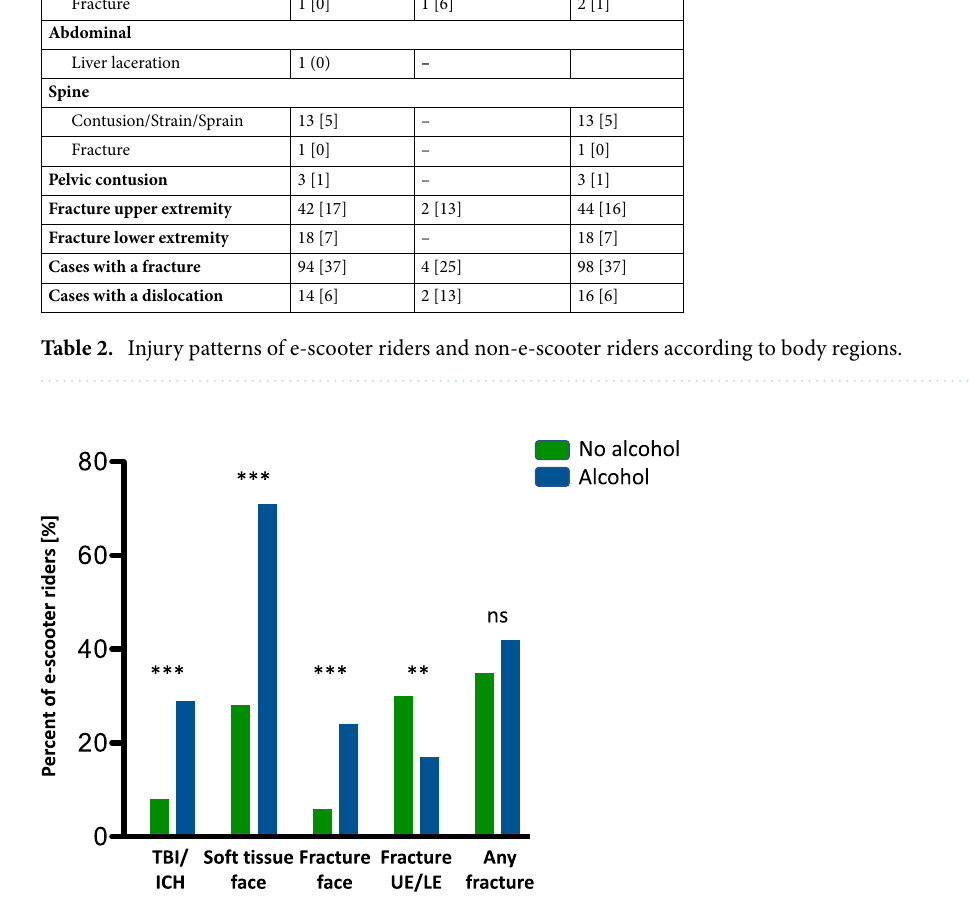
Figure 3. Bar graph depicting sober e-scooter riders vs. those under the influence of alcohol. Depicted as bars in percent of total of those who sustained a traumatic brain injury (TBI) or intracranial hemorrhage (ICH), soft tissue injury to the face, maxillofacial fracture, upper or lower extremity fracture (UE/LE), and any fracture. Statistical analysis with Mann–Whitney test (* p < 0.05, ** p < 0.01, *** p <